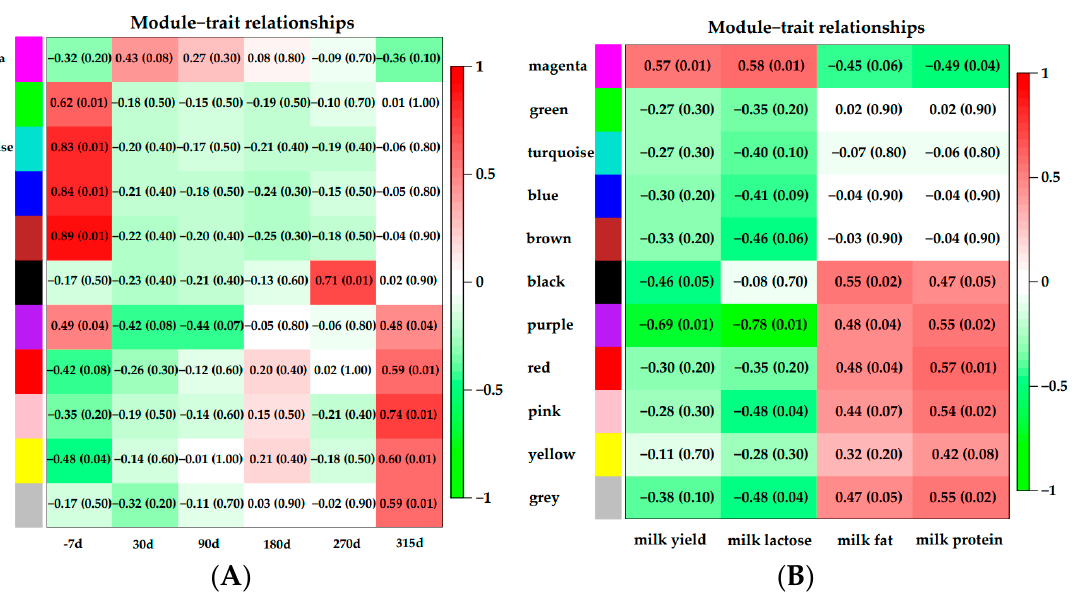
Figure 5. Module–trait relationship analysis. Each row corresponded to a module characteristic gene (eigengene), and each column corresponded to a trait. ( A ): the correlations of modules and lactation stages; ( B ): the correlations of modules and milk yield or component. Each cell contained a corresponding correlation and p -value.